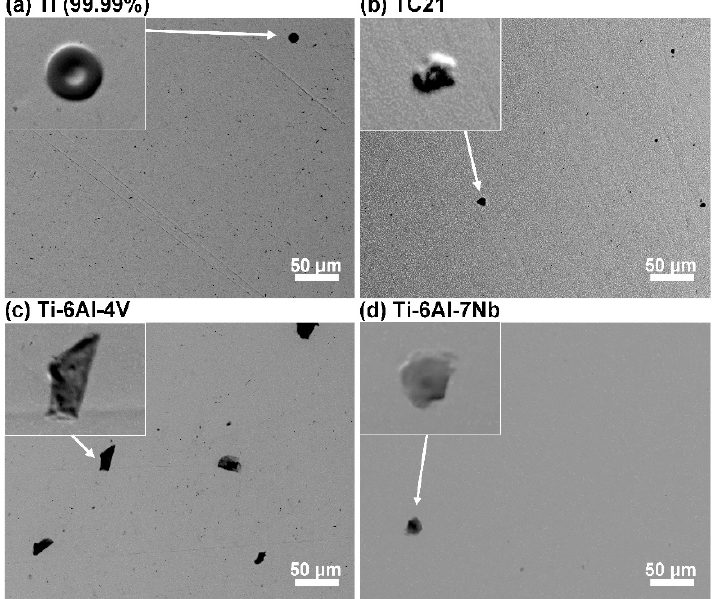
Figure 10. SEM micrographs taken in secondary electron mode for each investigated sample: ( a ) pure Ti as a reference; ( b ) TC21 alloy; ( c ) Ti-6Al-4V; and ( d ) Ti-6Al-7Nb at the end of one-week exposure in 0.9% NaCl at 37 ◦ C. Magnification: × 500. In the inset, back-scatter electron topography mode images of selected surface defects. Magnification: ×